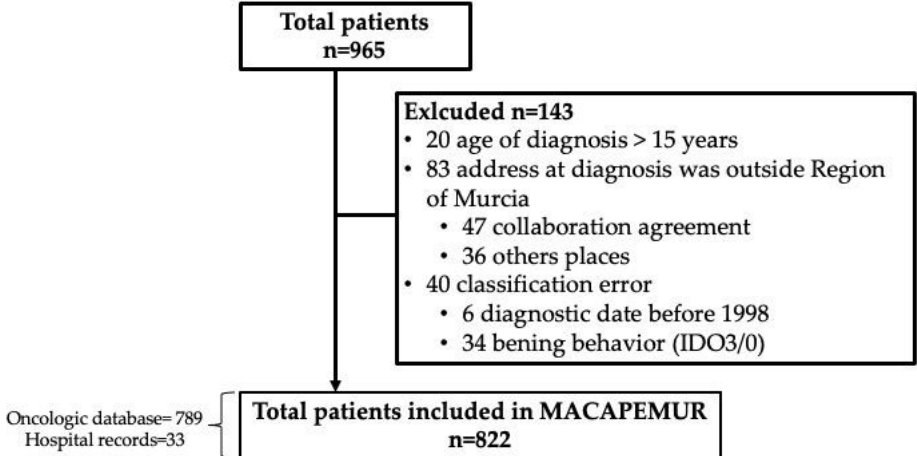
Figure 1. Total patients included in MACAPEMUR (1998 – 2020).